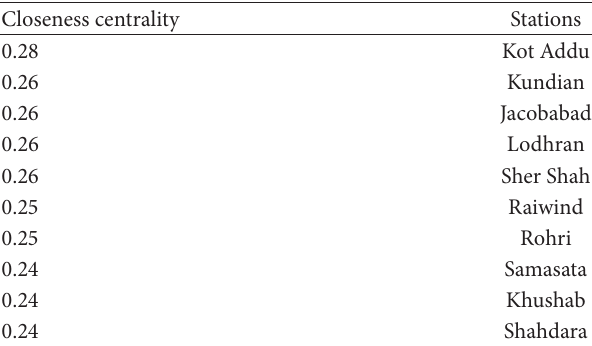
Table 3: Closeness centrality of top ten stations. Closeness